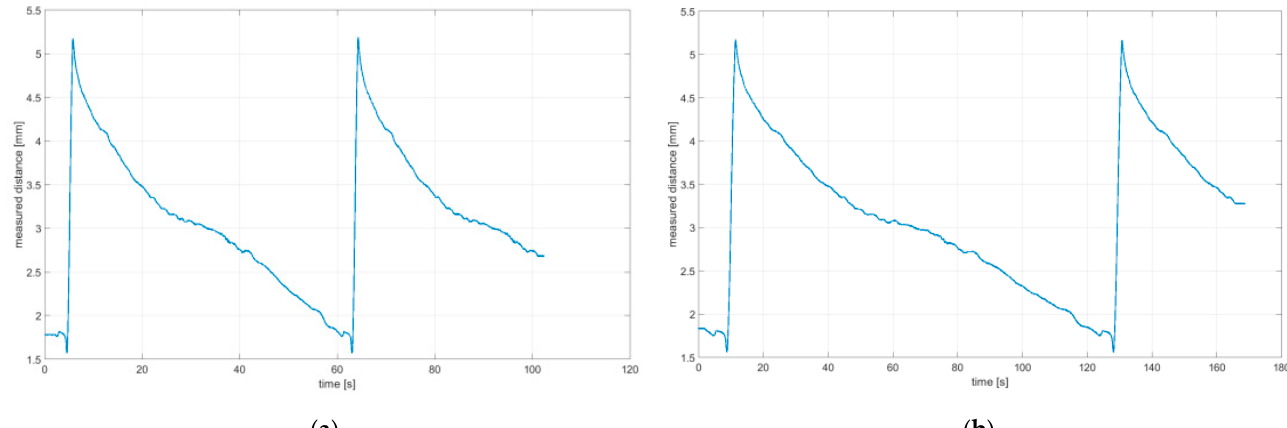
Figure 8. Distance measurement per time function: ( a ) 0°; ( b ) 60°.